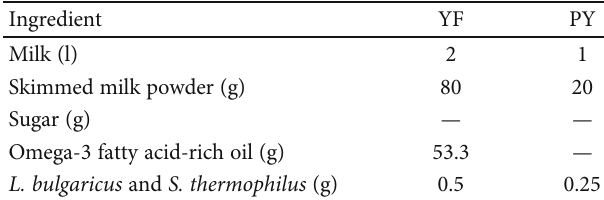
Table 1: Preparation of omega-3-forti fi ed